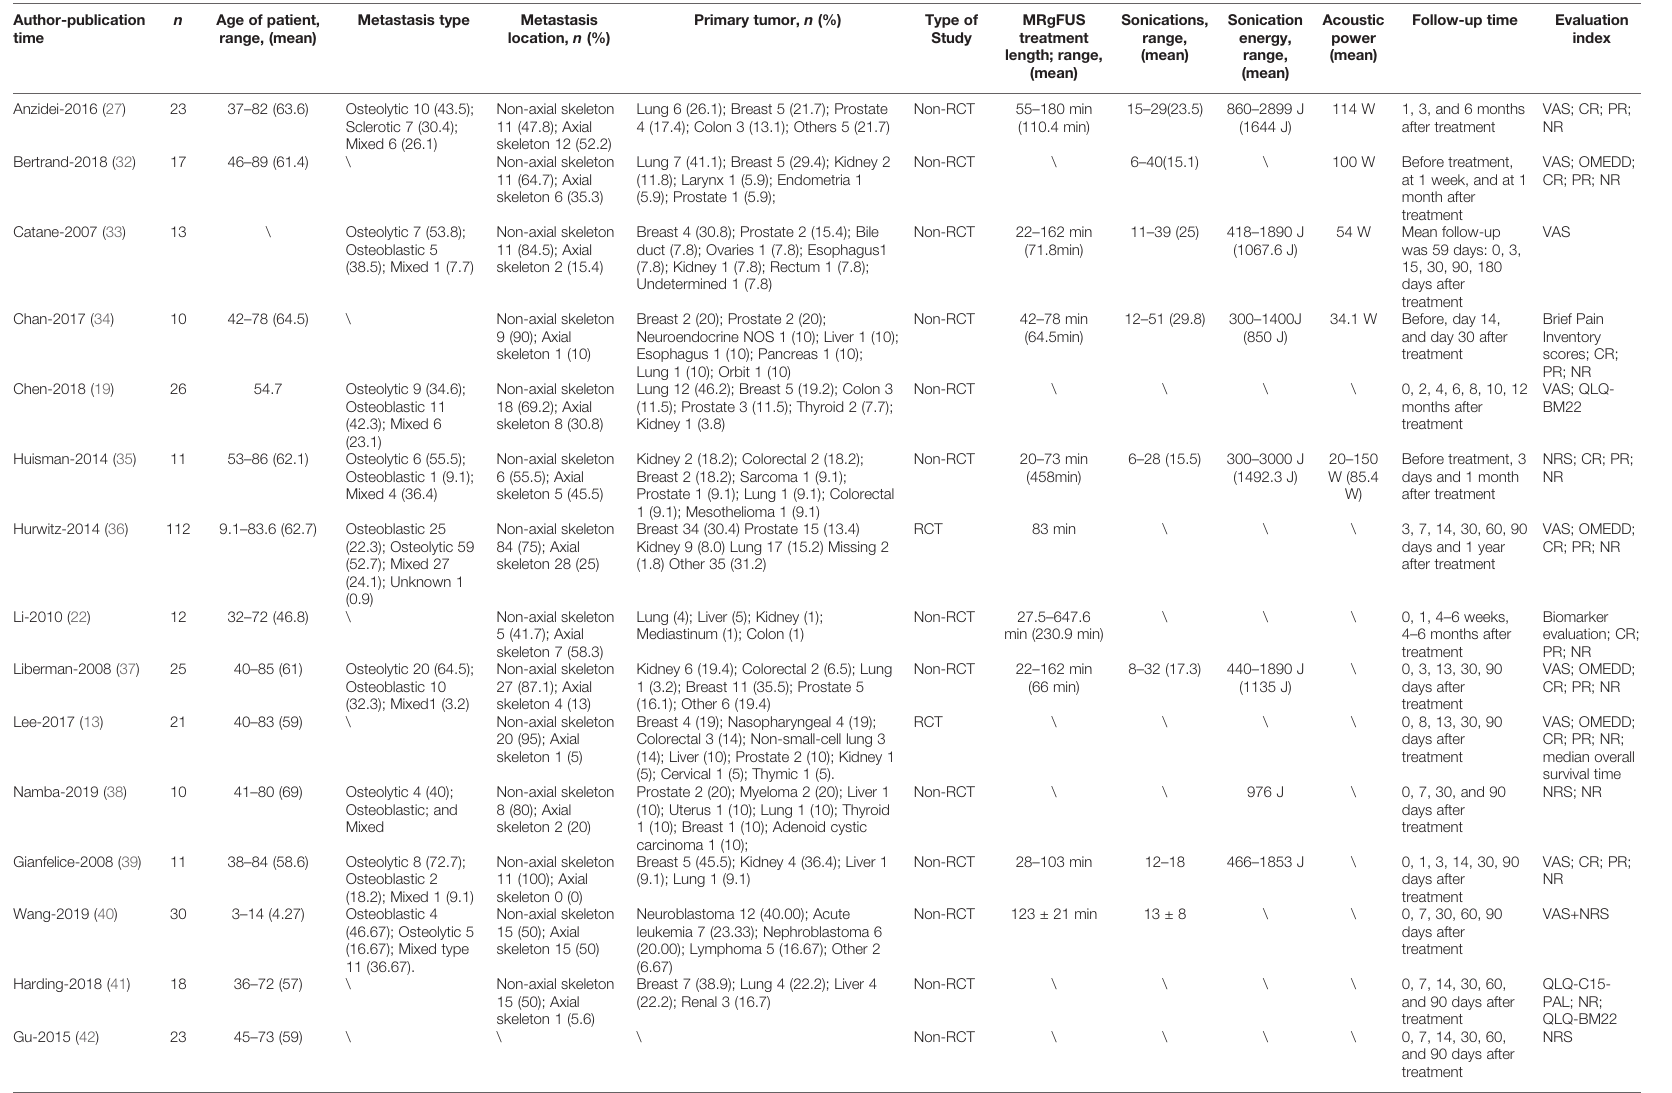
TABLE 1 | Basic characteristics of the included 15 studies.